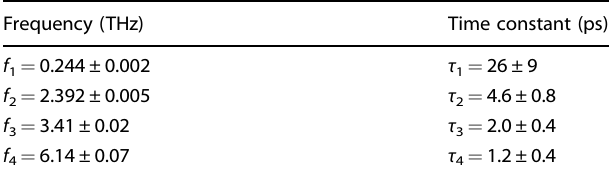
Table 1. Summary of key parameters obtained from a fi t of the data in Fig. 1c, d at 3.2 mJ/cm 2 absorbed fl uence to the model of Eq. 1.